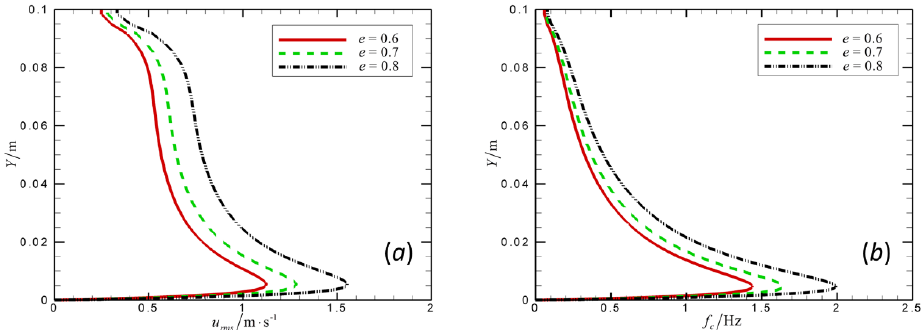
Figure 7. Influence of the interparticle collision restitution coefficient on the fluctuation of sand movement. ( a ) Variation with height of the turbulent RMS sand velocity. ( b ) Variation with height of the interparticle collision frequency. In both panels, the interparticle collision restitution coefficient increases from 0.6 to 0.8 with an increment of 0.1, with the conditions d s = 250 μ m and u = 0.395 m/s.